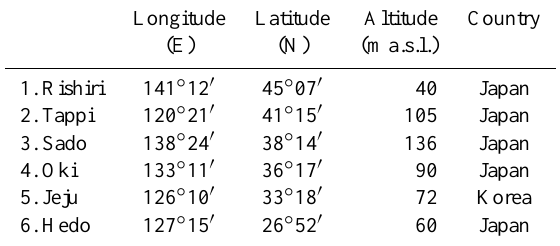
Table 1. Description of the EANET remote observation sites used in this study. Each station is depicted in Fig.